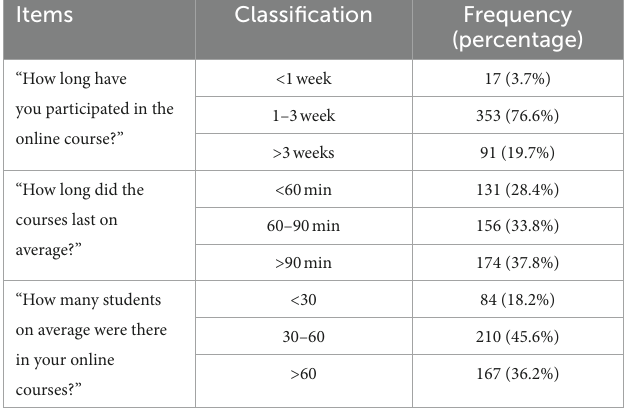
TABLE 1 Information of online courses.